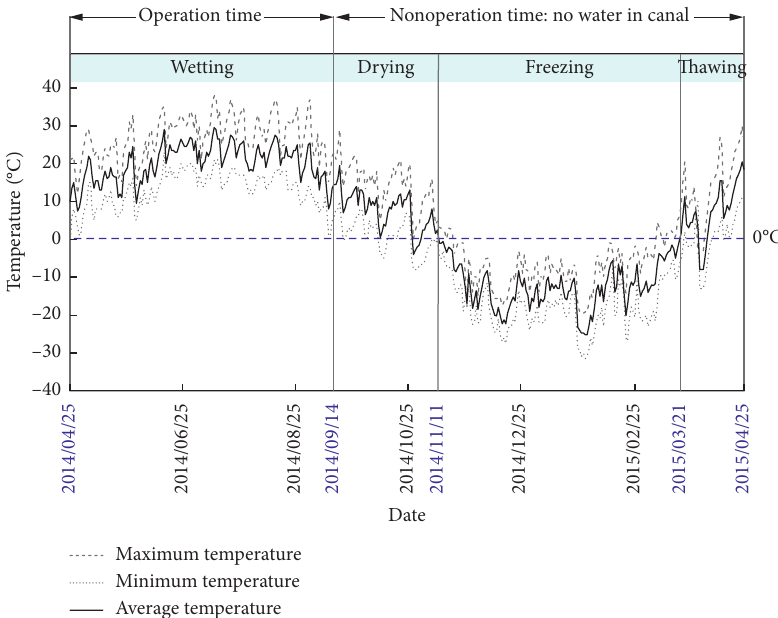
Figure 2: Temperature observed by a weather station along the canal in Xinjiang